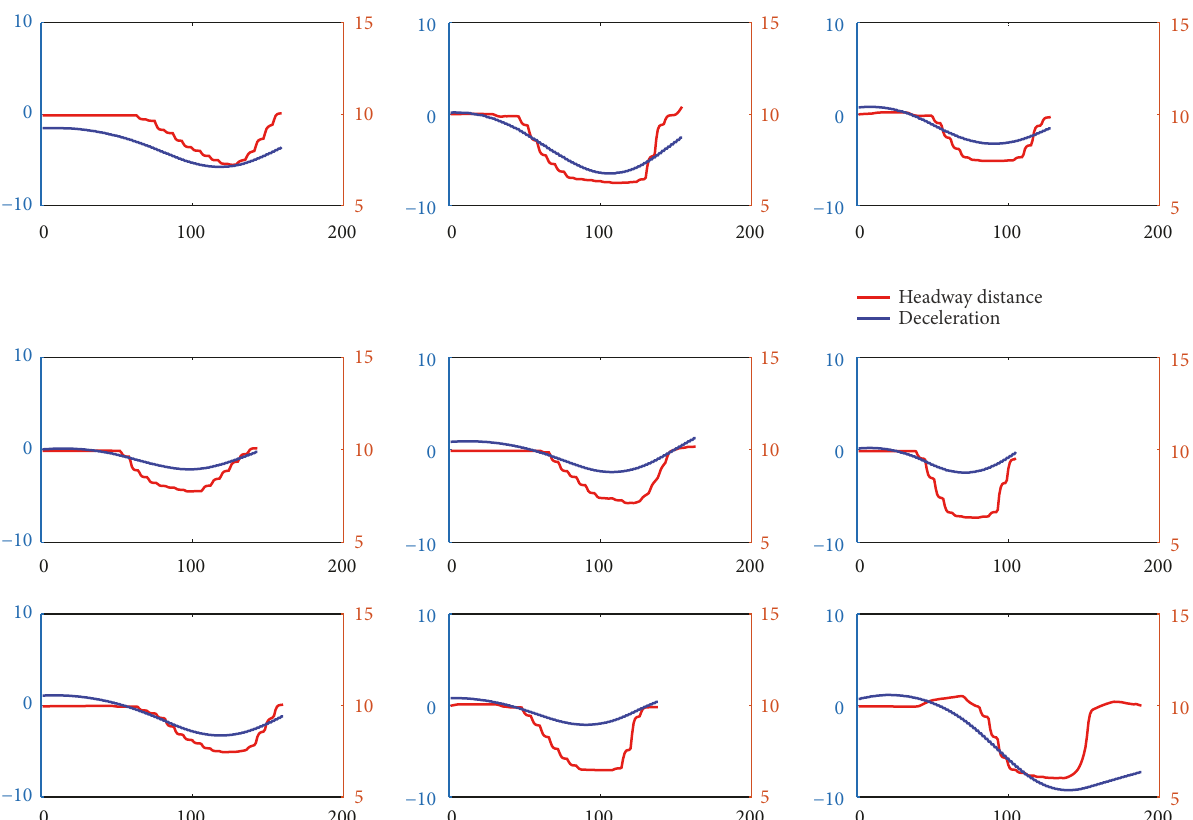
Figure 5: Deceleration and headway distance from the lead vehicle’s brake onset to the end of the following vehicle’s brake of selected near- crashes.